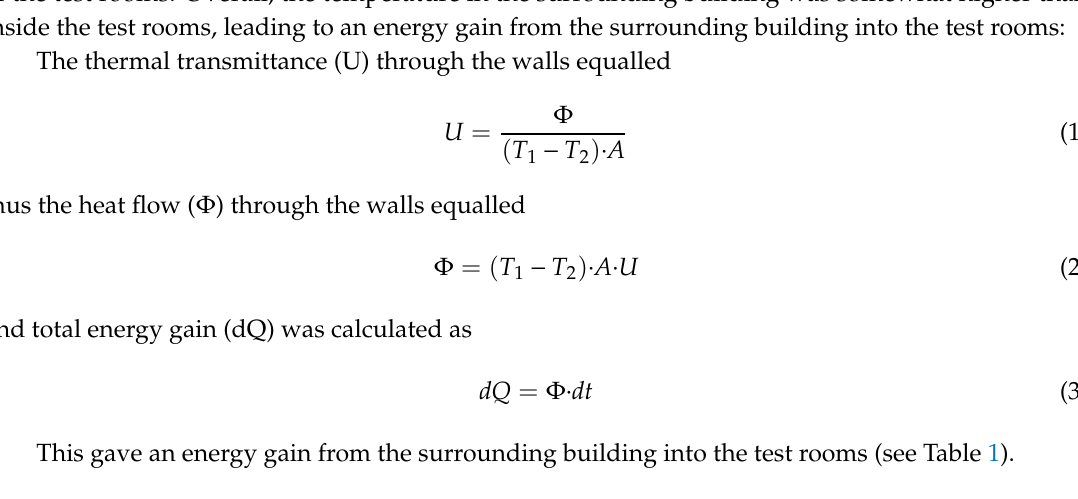
Figure 11. Daily mean indoor temperatures in room B, as measured by the ventilation system (Room B) and by the TESTO device (TESTO Room B).